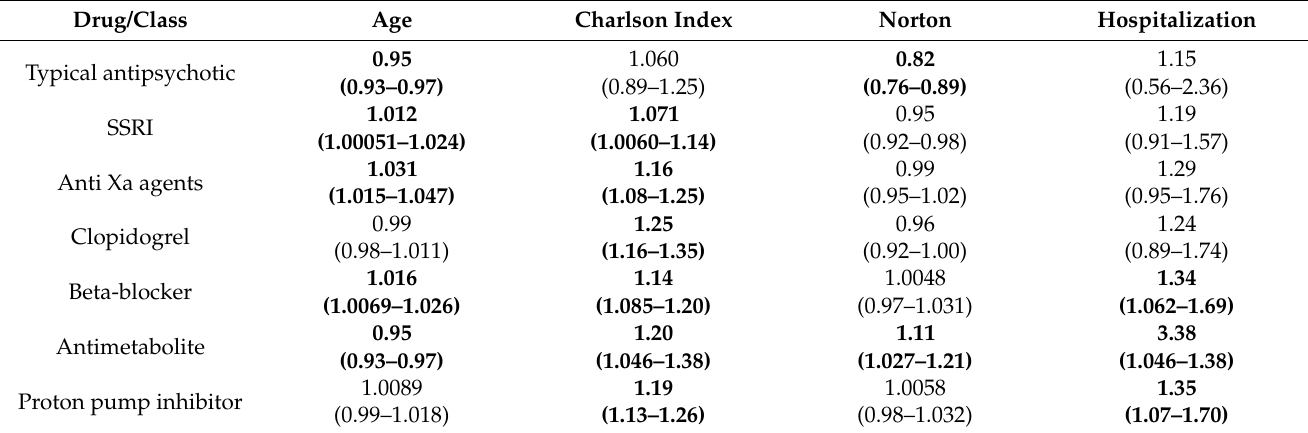
Table 3. Patient variables associated with non-antimicrobial drug exposure.